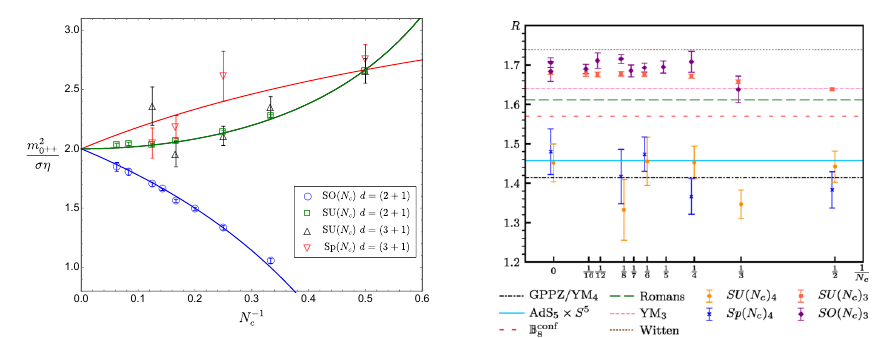
Figure 2. Numerical results and extrapolations towards the large N c limit, showing the convergence of the SU( N c ), Sp( N c ) and SO( N c ) Yang-Mills theories: (left) Casimir scaling in the lightest scalar glueballs, and (right) mass ratio between the lightest scalar and tensor glueballs, R ≡ m 2 ++ / m 0 ++ . The constant η is defined in Eq. (1). Figures from Refs. [11, 13,